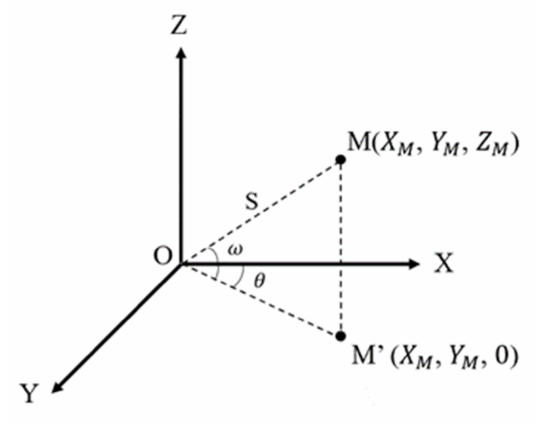
Figure 7. Schematic diagram of monitoring point coordinate